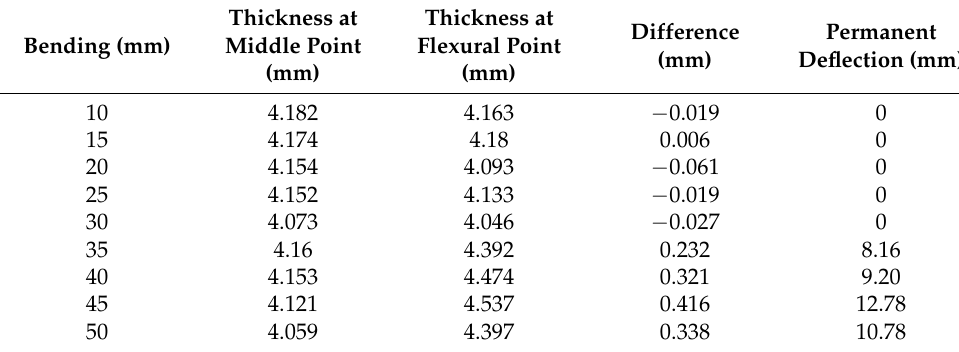
Table 1. The table indicates the location of protrusion points compared to the middle of the test specimens (difference in mm), with the values of permanent deflection.